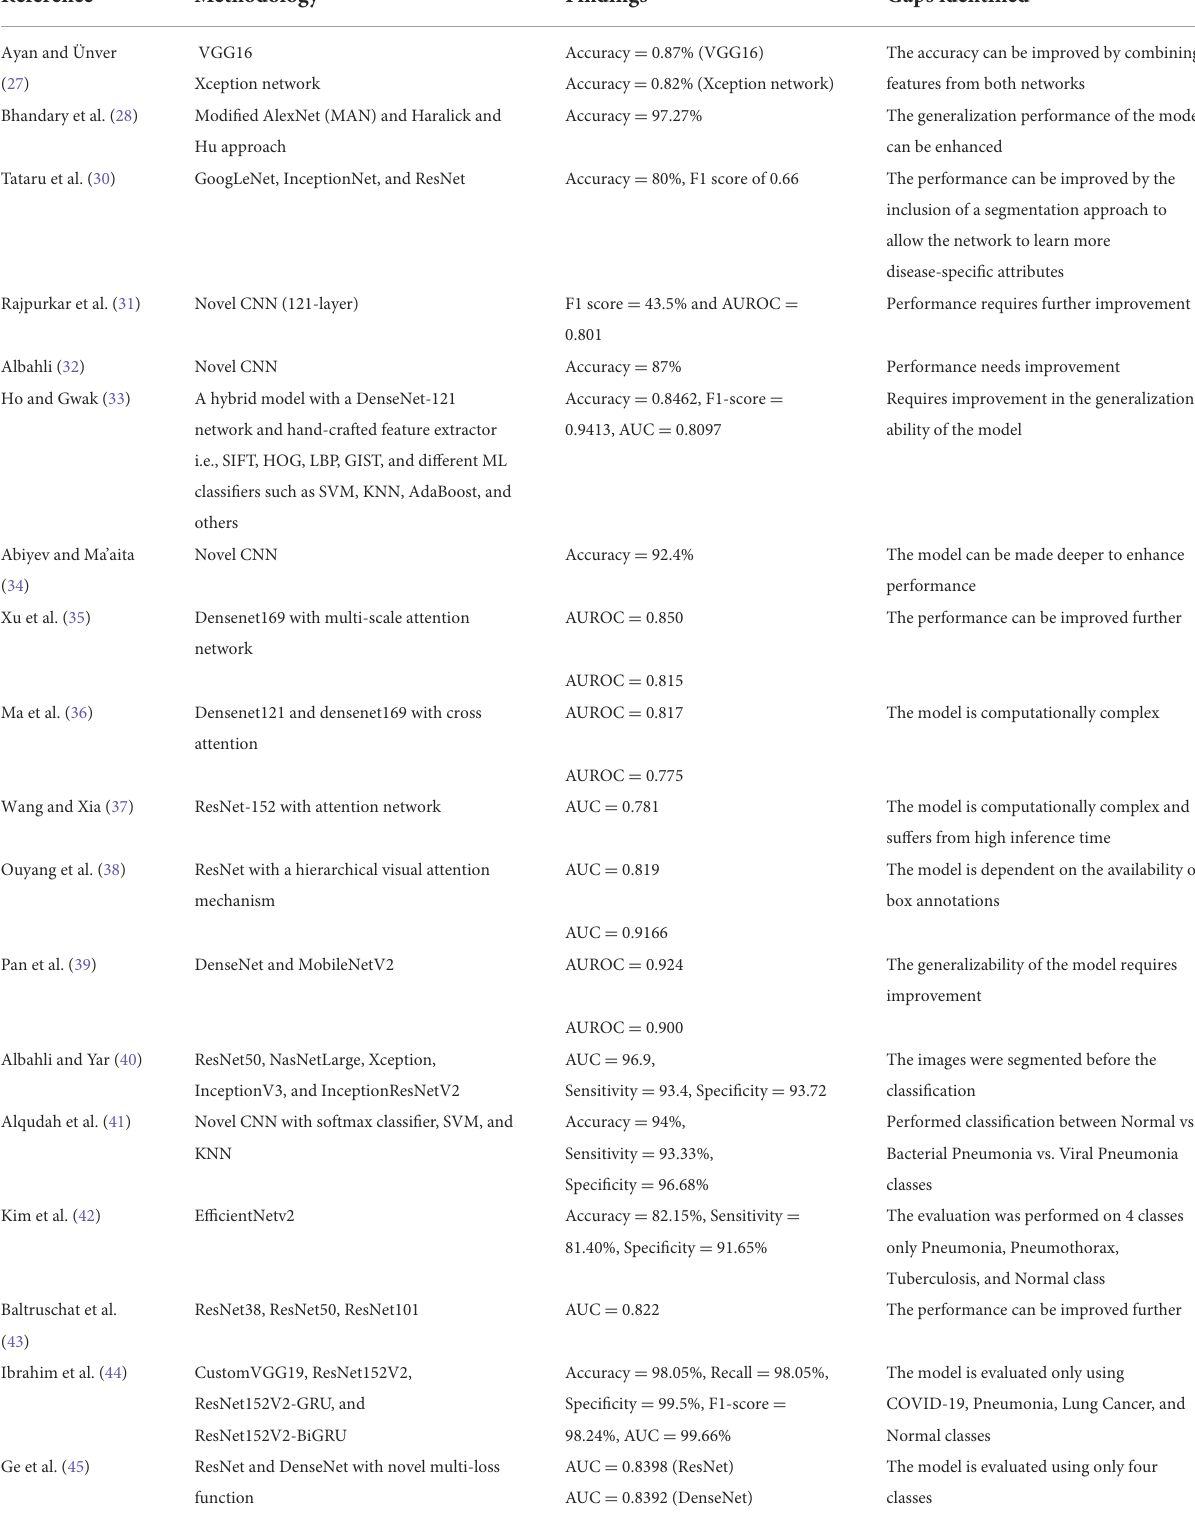
TABLE 1 A comparison of the multi-class chest disease